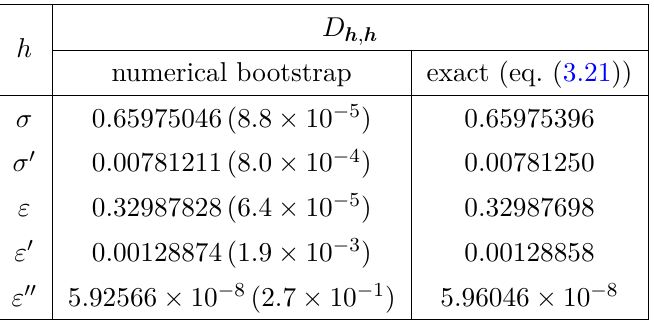
Table 1 . Results of the numerical bootstrap for the Tricritical Ising CFT on the torus ( N = 2) . The first column indicates the channel labelled by the corresponding primary field, see eq. (D.4). The second column corresponds to the mean value for each structure constant calculated after considering 100 different sets of random points with κ = 0 . 22 . We have truncated the expansion in sphere conformal blocks and the elliptic recursion at level L, L 0 = 6 . In brackets, the coefficient of